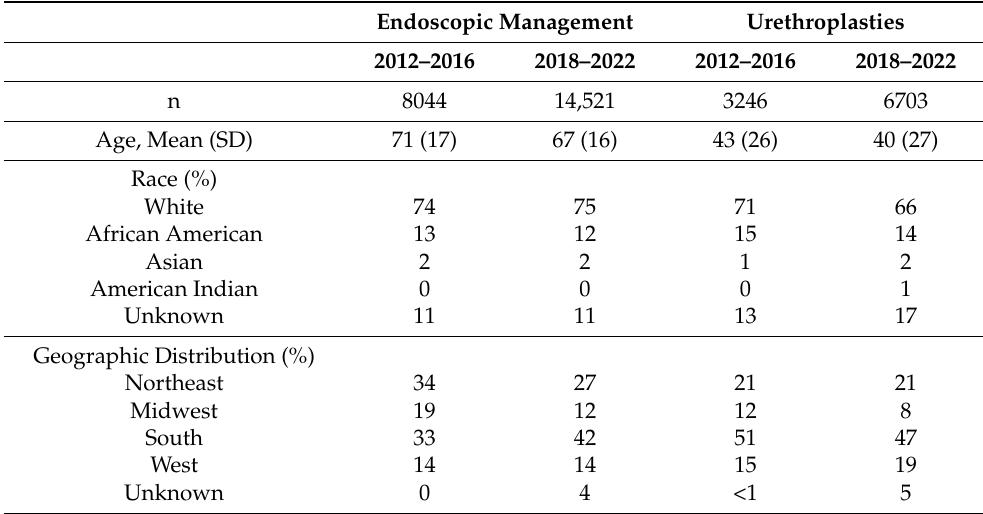
Table 2. Comparison of Male ≥ 18 Urethroplasty and Endoscopic management Procedures Centered Around 2017 Guideline Changes.